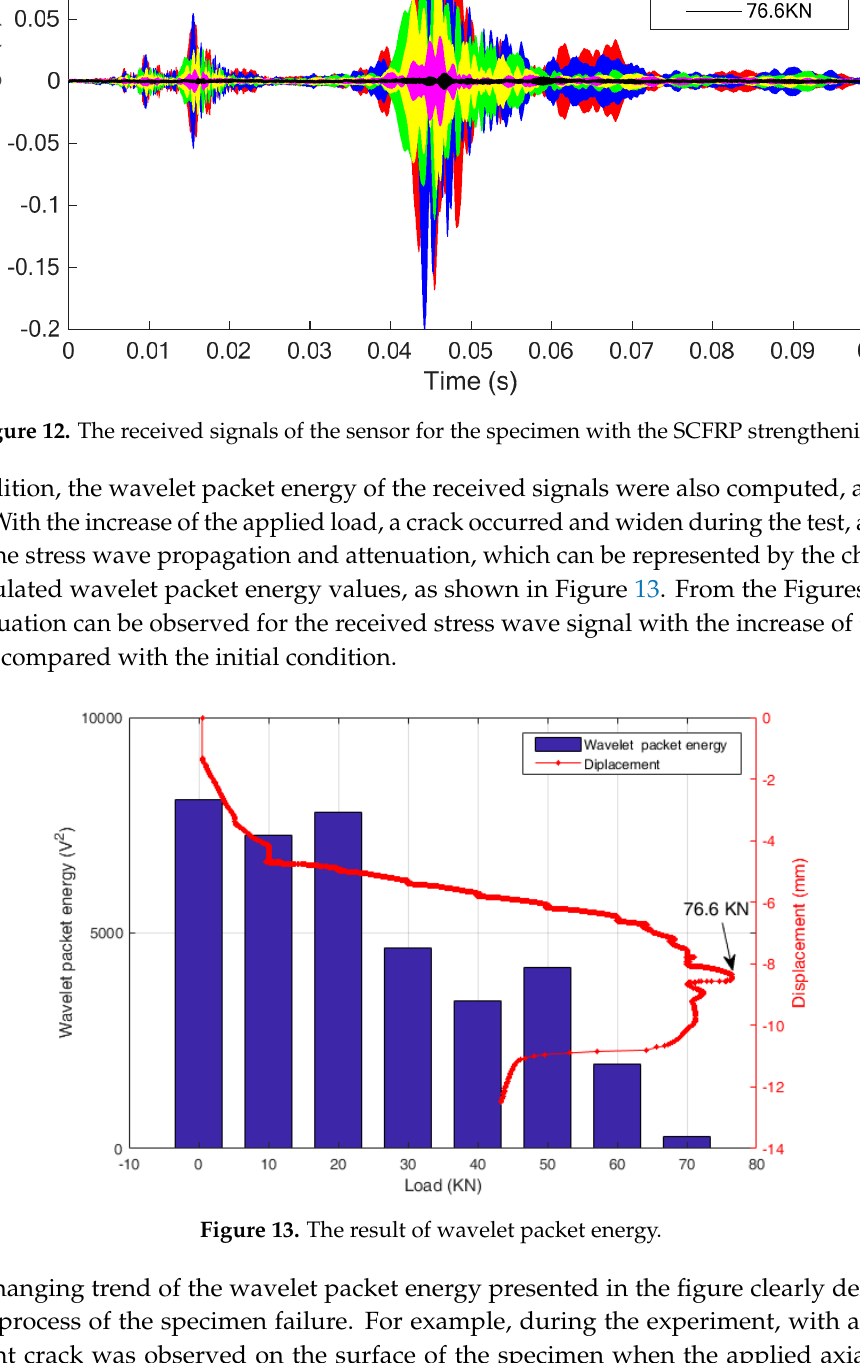
Figure 13. The result of wavelet packet energy.